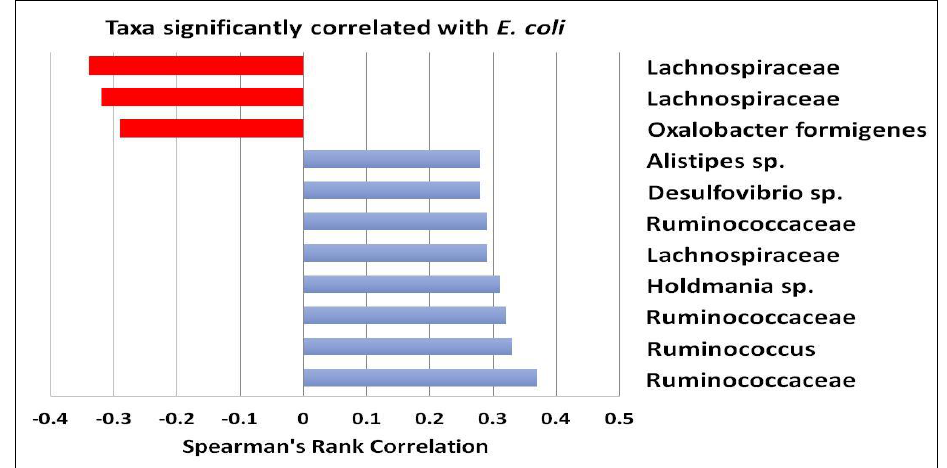
Figure 3. Using Spearman’s rank, several ASVs were found to be significantly negatively correlated (red bars) or positively correlated (blue bars) with E. coli ASVs. Significant values were considered q < 0.10.